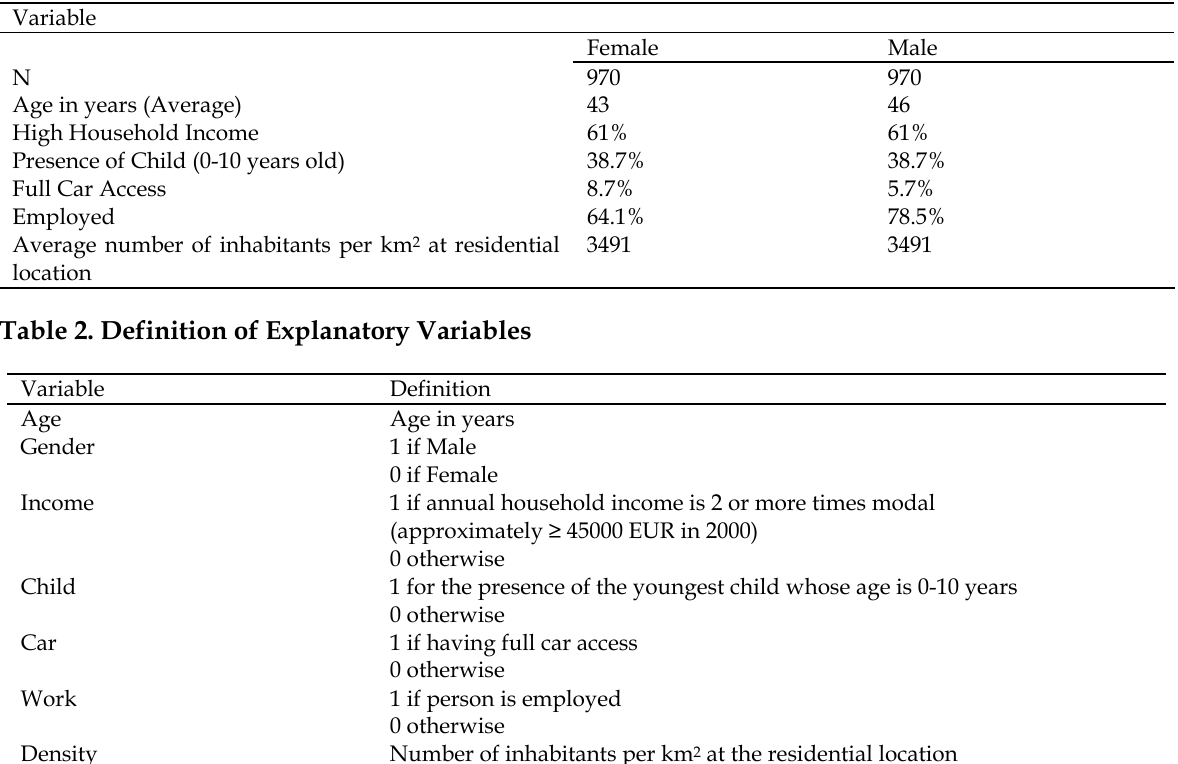
Table 1. Summary of Sample Characteristics